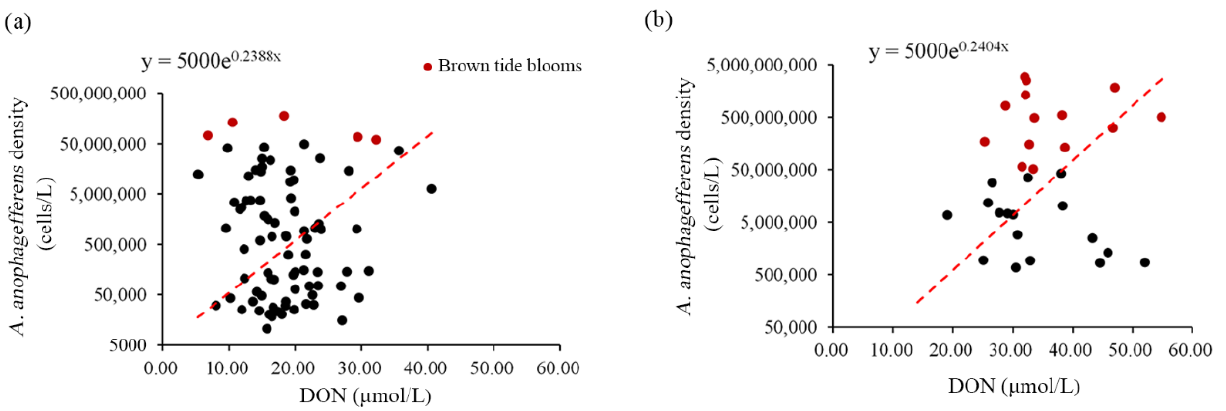
Figure 7. The relationship between A. anophagefferens cell density and DON in 2013 ( a ) and 2014 ( b ).